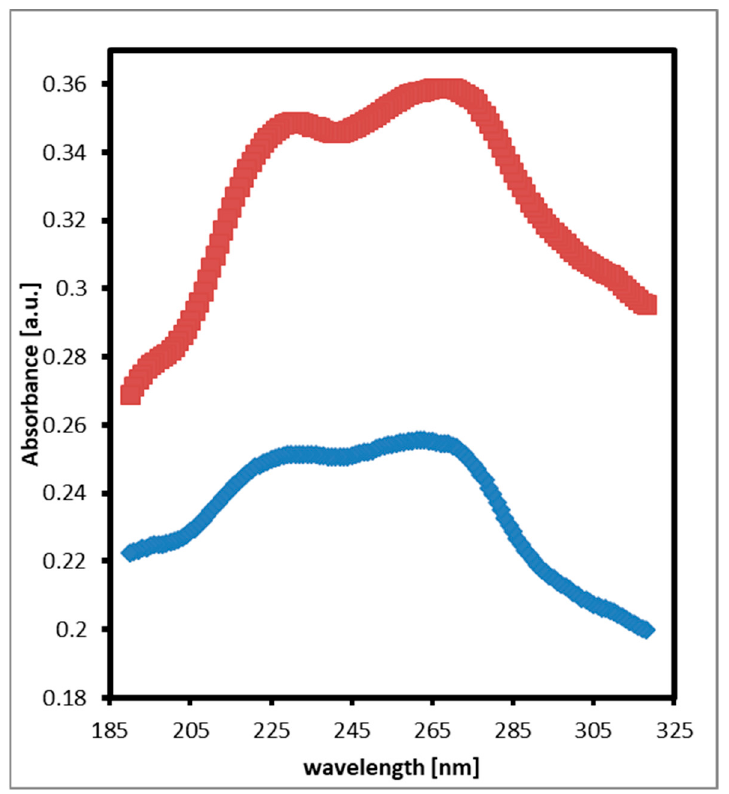
Figure 1. Absorbance spectrum of TNT nanofilms at 50 °C (bottom) and 70 °C (top) showing no shift in the absorbance peaks upon temperature change.